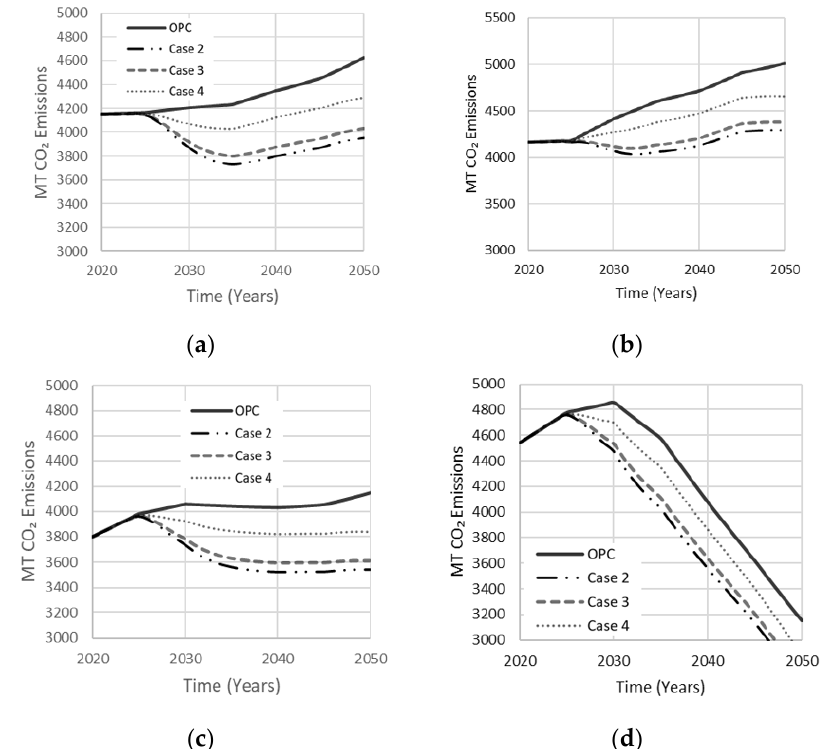
Figure 15. Effect of the single precursor system with optimal hybrid activator mixes on net emissions released in ( a ) Low Variability Scenario; ( b ) High Variability Scenario; ( c ) Carbon Tax Increase Scenario; ( d ) Population Stabilization Scenario.